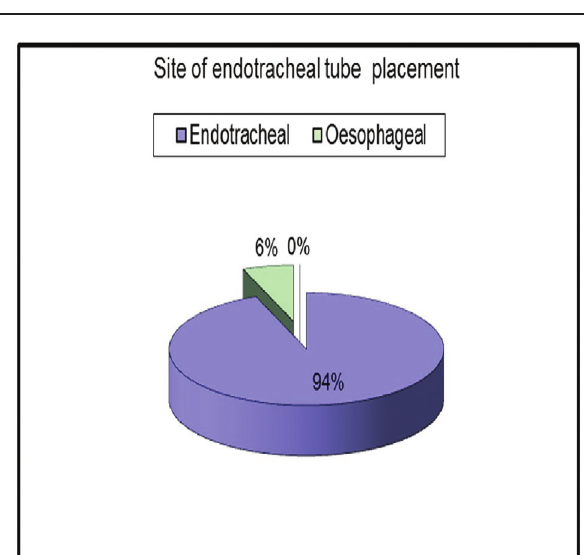
Site of endotracheal tube placement.